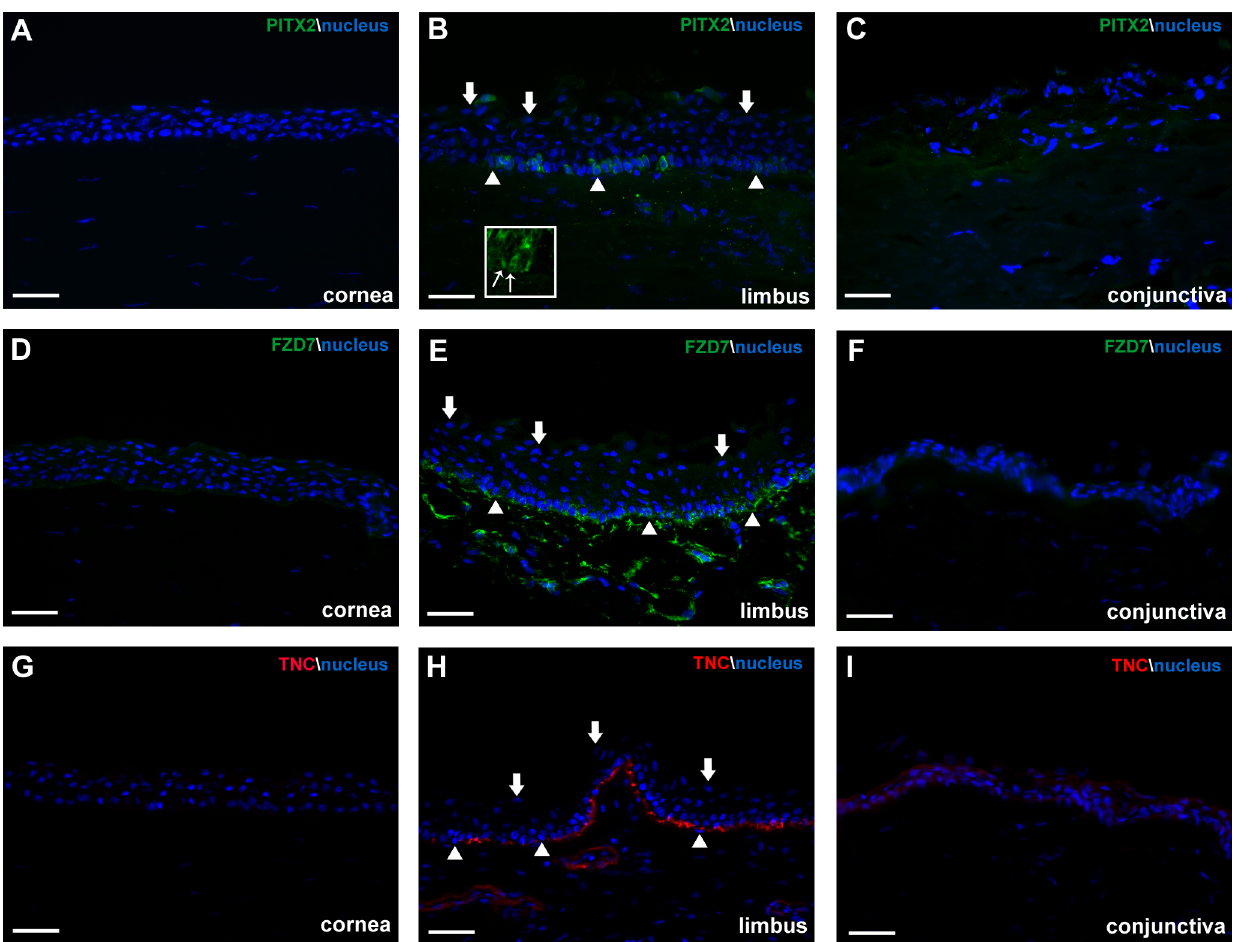
Figure 4. Protein expression of selected limbal transcripts in human ocular tissue. A) Minimal expression of PITX2 was observed in the cornea. B) Distinct PITX2 cytoplasmic expression was present in pockets within the basal layer and suprabasal layer of the limbal epithelium. Insert highlights both PITX2 cytoplasmic and nuclear localization in the basal epithelial cells. Thin arrows indicate cells with PITX2 nuclear localization. C) Minimal expression of PITX2 was also observed in the conjunctiva. D) Weak expression of FZD7 was detected in the basal layer of the cornea. E) Highly localized FZD7 expression was observed at the basal layer of the limbal epithelium. F) We observed low expression in the suprabasal and superficial layers of the conjunctiva for FZD7. G) Minimal expression of TNC was observed in the cornea, while distinct expression was present in the subepithelial stroma along the limbus (H). (I) We detected minor expression of TNC in the suprabasal and superficial layers of the conjunctiva. Thick arrows represent examples of superficial epithelial cells and arrowheads represent examples of basal epithelial cells in the limbus. Scale bar, 50 m